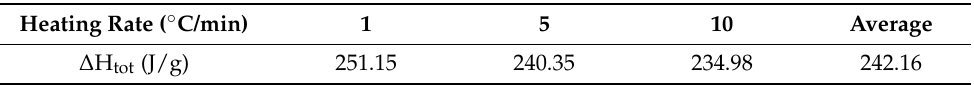
Table 1. The total heat of reaction determined by the dynamic DSC tests with different heating rates. Heating Rate ( ◦